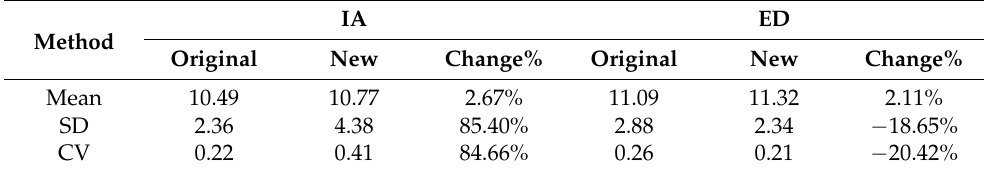
Table 4. Mean, SD and CV of FT4 transformations into LC-MS/MS scale by linear transformation.